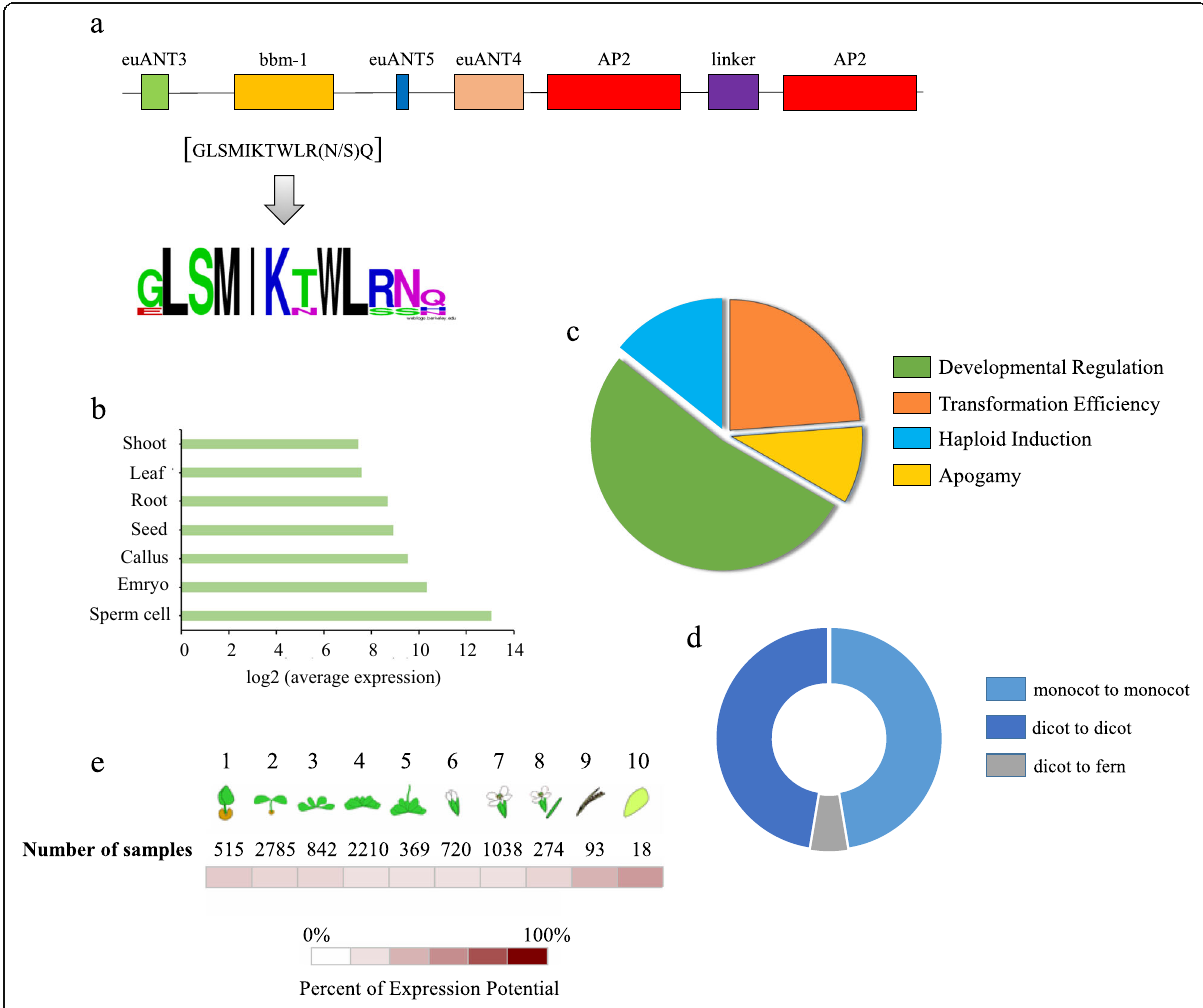
Fig. 1 a domains in BBM gene and the amino acid sequence of bbm-1 motif along with sequence logo, b tissue specific expression and developmental regulation of AtBBM gene ( Arabidopsis thaliana ), c the classification of studies for BBM genes (BBM1 and BBM2) and the distrubution of the subjects into four main categories: developmental regulation, transformation efficiency, haploid induction and apogamy, d fern, monocot and dicot classification of BBM studies. 1: germinated seed, 2: seedling, 3: young rosette, 4: developed rosette, 5: bolting, 6: young flower, 7: developed flower, 8: flowers and siliques, 9: mature siliques, 10: